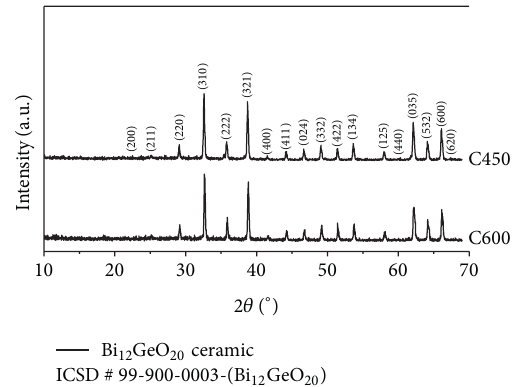
Figure5:X-raydiffractionpatternsofthesamplesC450(calcinedat 450 ∘ C/1h and sintered at 750 ∘ C/1h) and C600 (calcined at 600 ∘ C/1h and sintered at 750 ∘